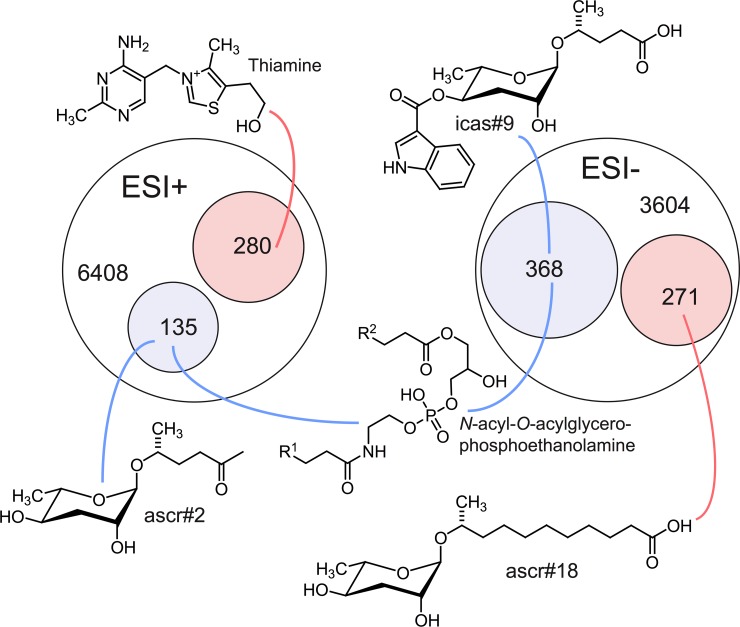
Loss of acox-1 results in large-scale changes to the global metabolome.Venn diagrams showing total numbers of detected features (6,408 and 3,604) and numbers of metabolites more than 3-fold up-regulated (pink) or down-regulated (blue) in LC-HRMS using positive-ion (ESI+) and negative-ion (ESI−) electrospray ionization in acox-1 mutants. Although most differentially detected features were unidentifiable, the chemical structures shown here represent examples of the most significantly up- or down-regulated compounds in identifiable metabolic classes. See S2 Table. acox-1, acyl-coenzyme A oxidase 1; ESI, electrospray ionization; HRMS, high-resolution mass spectrometry; LC, liquid chromatography.